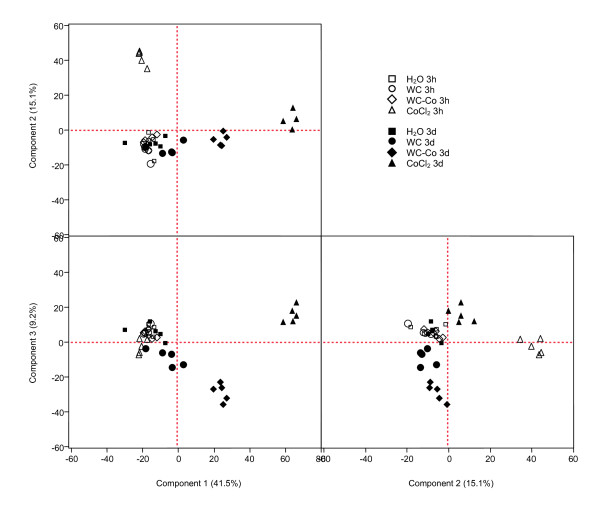
Principle component analyses. PCA of differentially expressed genes in HaCaT cells exposed for 3 h and 3 d to 30 μg/ml WC, 33 μg/ml WC-Co nanoparticles and 3 μg/ml CoCl2. Each symbol represents a biological replicate.